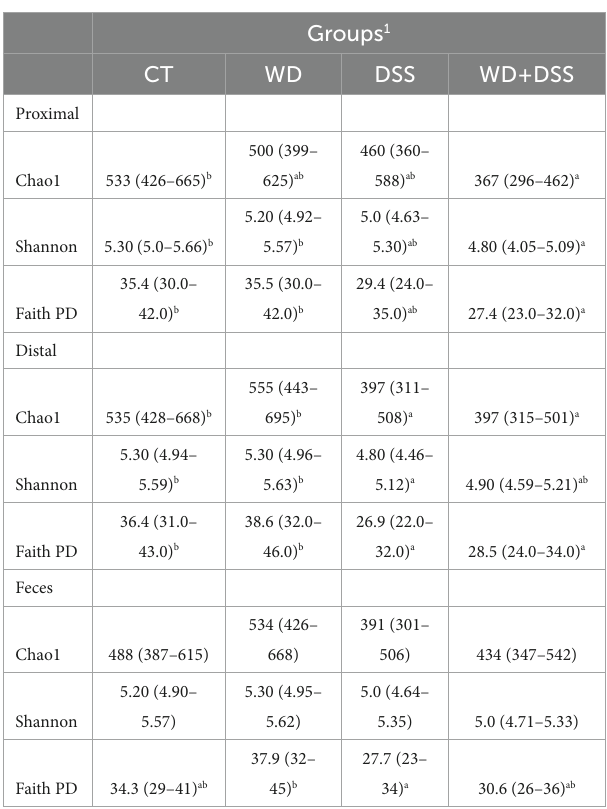
Degree of freedom